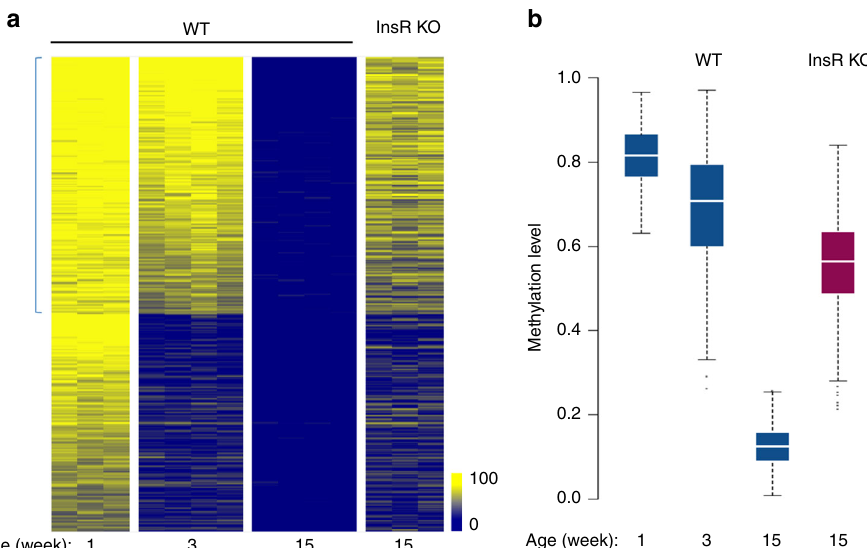
Fig. 6 Effect of insulin receptor ablation on postnatal demethylation. a Methylation heatmap (RRBS) showing 2800 DMRs from WT and InsR-de fi cient (1 day) hepatocytes that undergo demethylation postnatally from 1 week to 15 weeks. Note that InsR ablation affects mainly those sites ( n = 1520) that undergo demethylation after 3 weeks (marked with blue bar). b Box plot of methylation levels for these 1520 DMRs